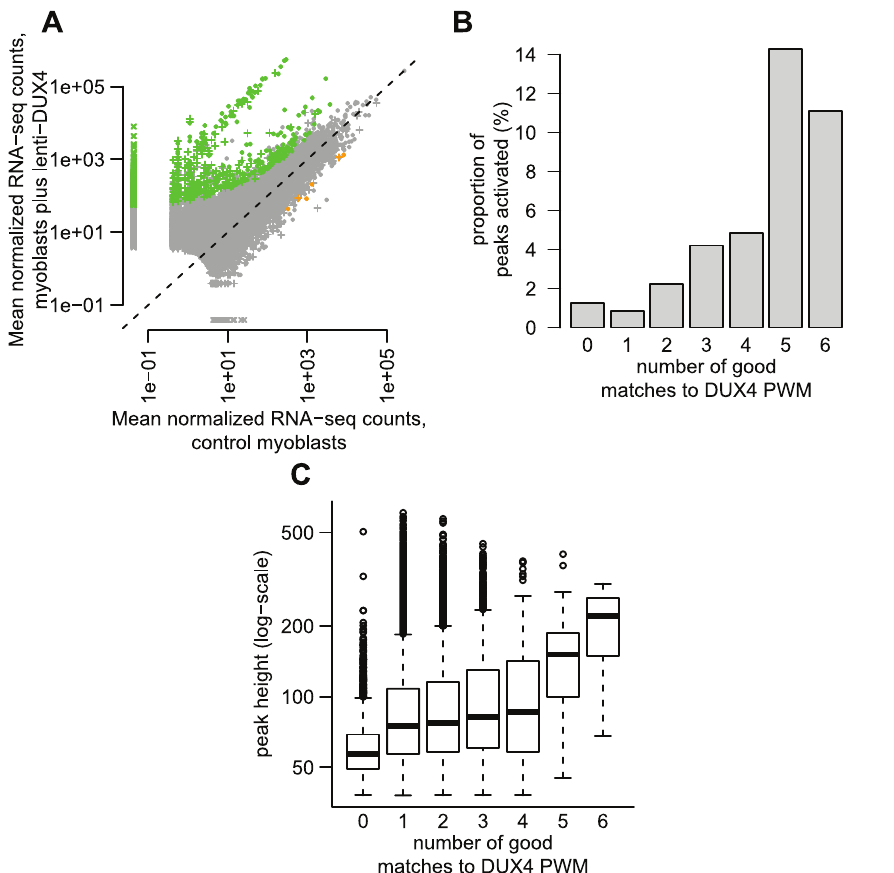
Figure 3. Some DUX4-bound repetitive elements are transcriptionally activated by DUX4. (A) , 1% of DUX4-bound regions show statistically-significant activation in response to DUX4 in our conservative analysis. We show normalized RNA-seq read counts within an arbitrary distance of 1 kb from DUX4-bound regions (peaks), comparing counts averaged over two myoblast lines that do not express DUX4 (x-axis) to counts averaged over two myoblast lines transduced with lentiviral DUX4 (y-axis). Only regions with at least 10 reads summed over all four samples are shown, and counts are plotted on a log scale. The 738 regions shown as green points show statistically significant activation in response to DUX4 ( $ 2-fold activation, FDR-adjusted p-value # 0.1) and the 6 orange points show significant repression (same thresholds). Regions surrounding DUX4- bound repeats are shown as ‘‘ + ’’ symbols, with dots representing DUX4-bound unique regions. Some regions (‘‘x’’ symbols) had normalized counts of 0 in one condition and are plotted at an arbitrary low value so they appear on a log-scale. (B) DUX4-bound regions with more predicted DUX4 binding motifs are more likely to be transcriptionally activated. The y-axis value gives the percentage of regions that are transcriptionally activated by DUX4 ( $ 2-fold, FDR-adjusted p-value # 0.1). (C) DUX4-bound regions with more predicted DUX4 binding motifs have greater DUX4 occupancy, using ChIP-seq peak height as a proxy for DUX4 occupancy (shown on a log-scale).